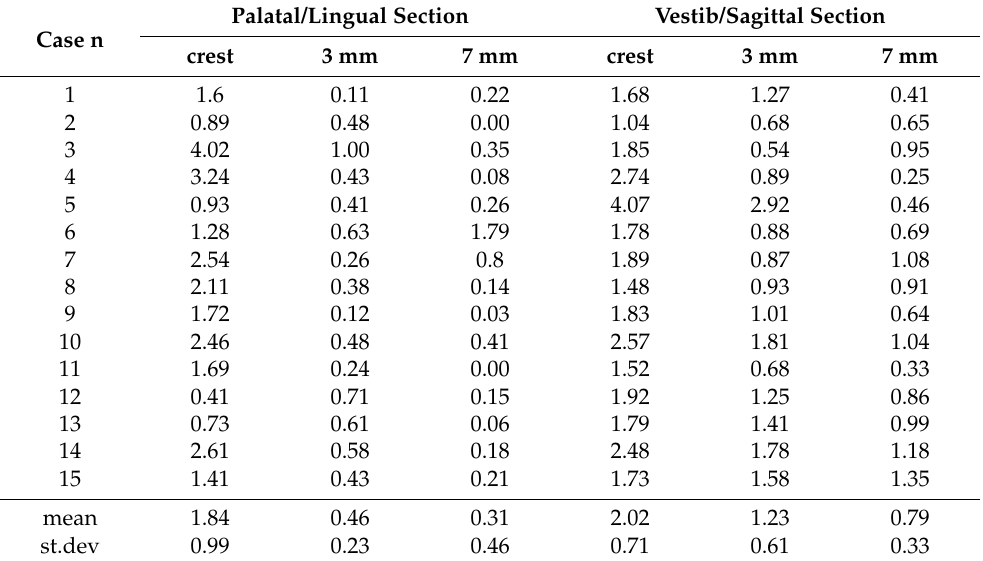
Table 1. Mean contraction (in mm) of the cortical plate at different levels, evaluated by 3D superim- position of scanned stone